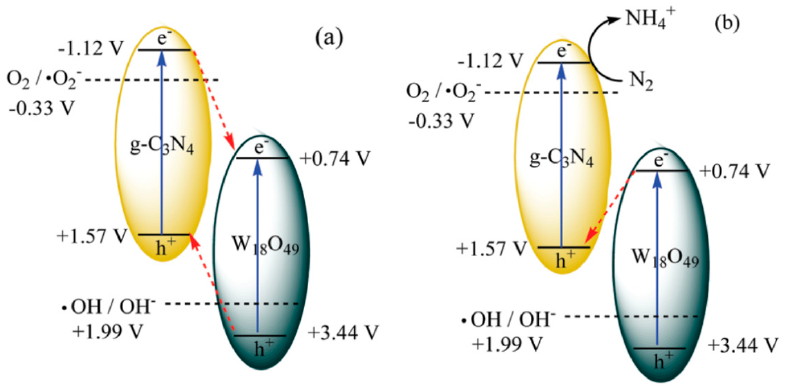
Figure 9. The possible double charge transfer mechanism ( a ) and the Z − scheme mechanism ( b ) over − C 3 N 4 W 18 O 49 (0.6)/g − C 3 N 4 [106]. W 18 O 49 (0.6)/g